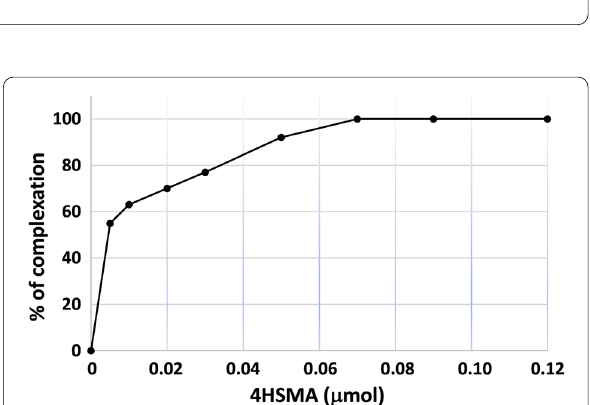
Fig. 3 AMA (GBq/μmol) determination of 68 Ga‑4HMSA AMA calculated via titration of the chelator with purified 68 GaCl